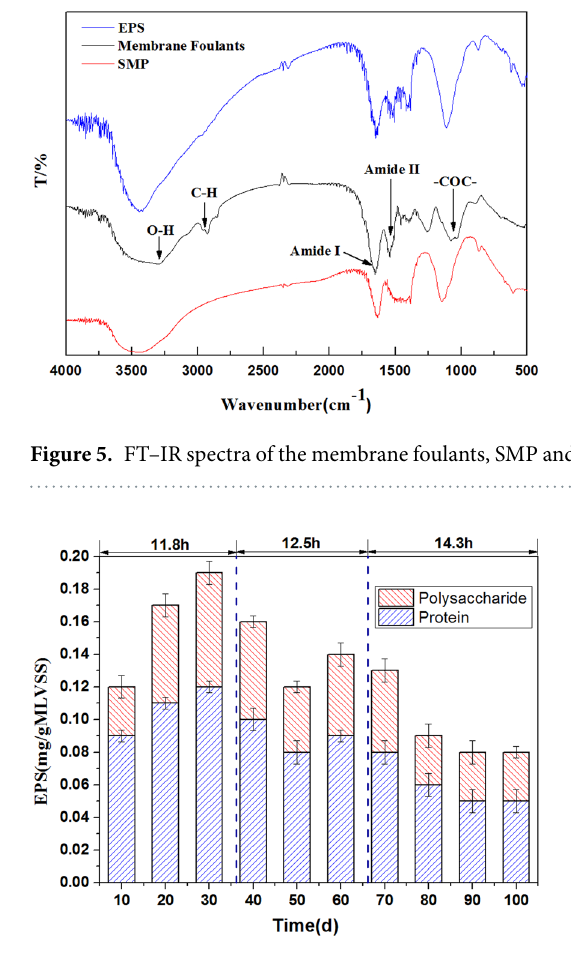
Figure 6. Change of EPS against operation time. Note: the EPS concentrations were shown in forms of ‘average value ± standard